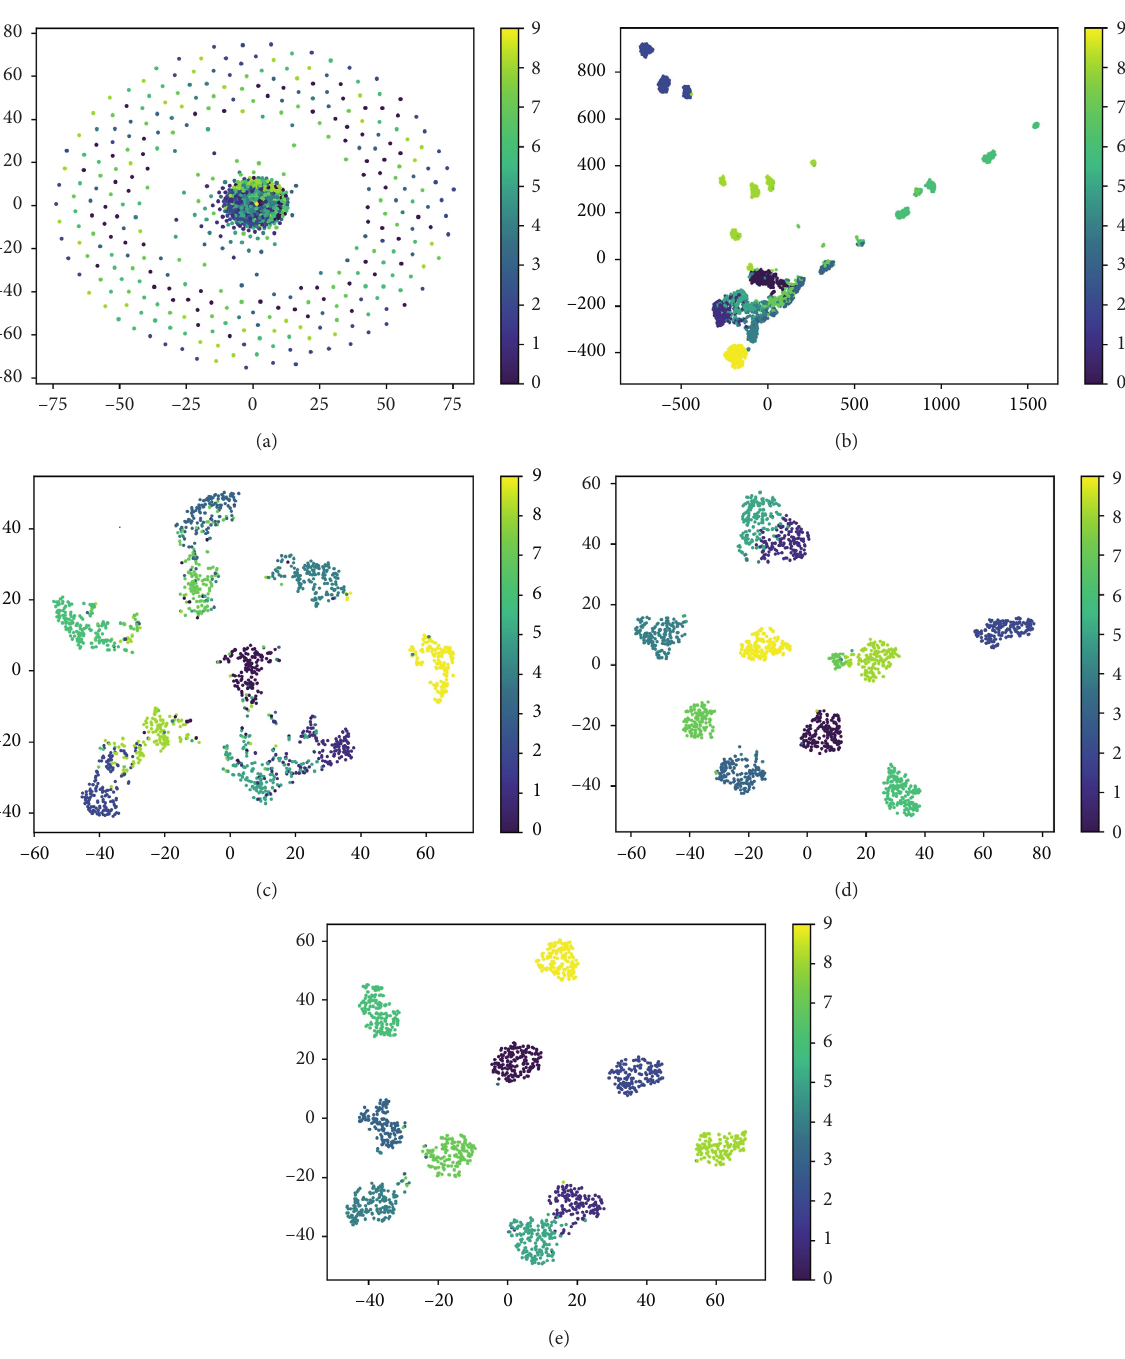
Figure 7: Visualization of the input extracted from the last layer of different test models via the t-SNE method: (a) raw input signals; (b) SAE; (c) BP Neural Network; (d) WDCNN; and (e)